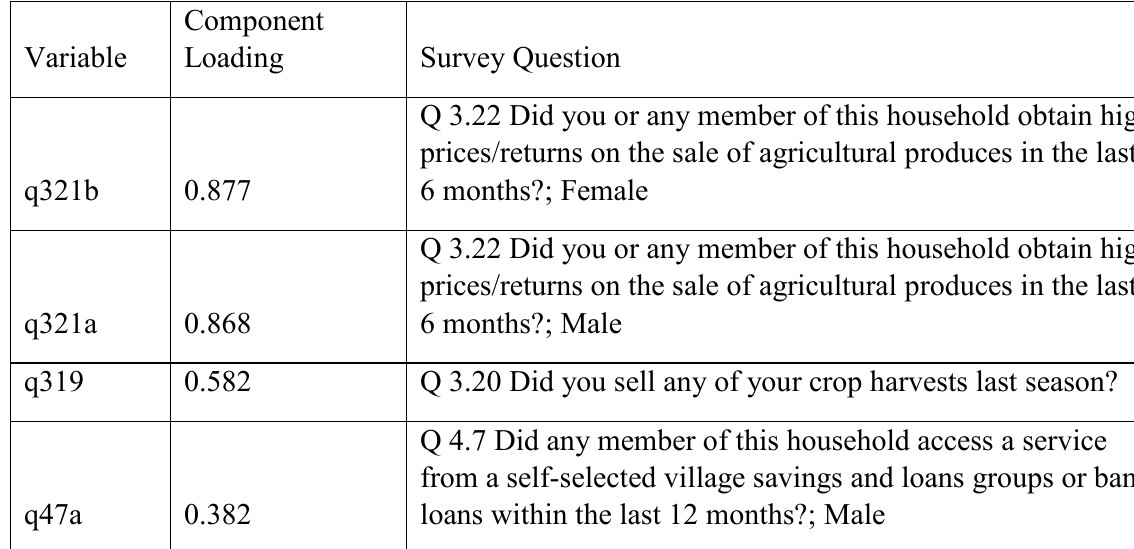
Table 1.44: Variables defining Transformative Resilience PC3